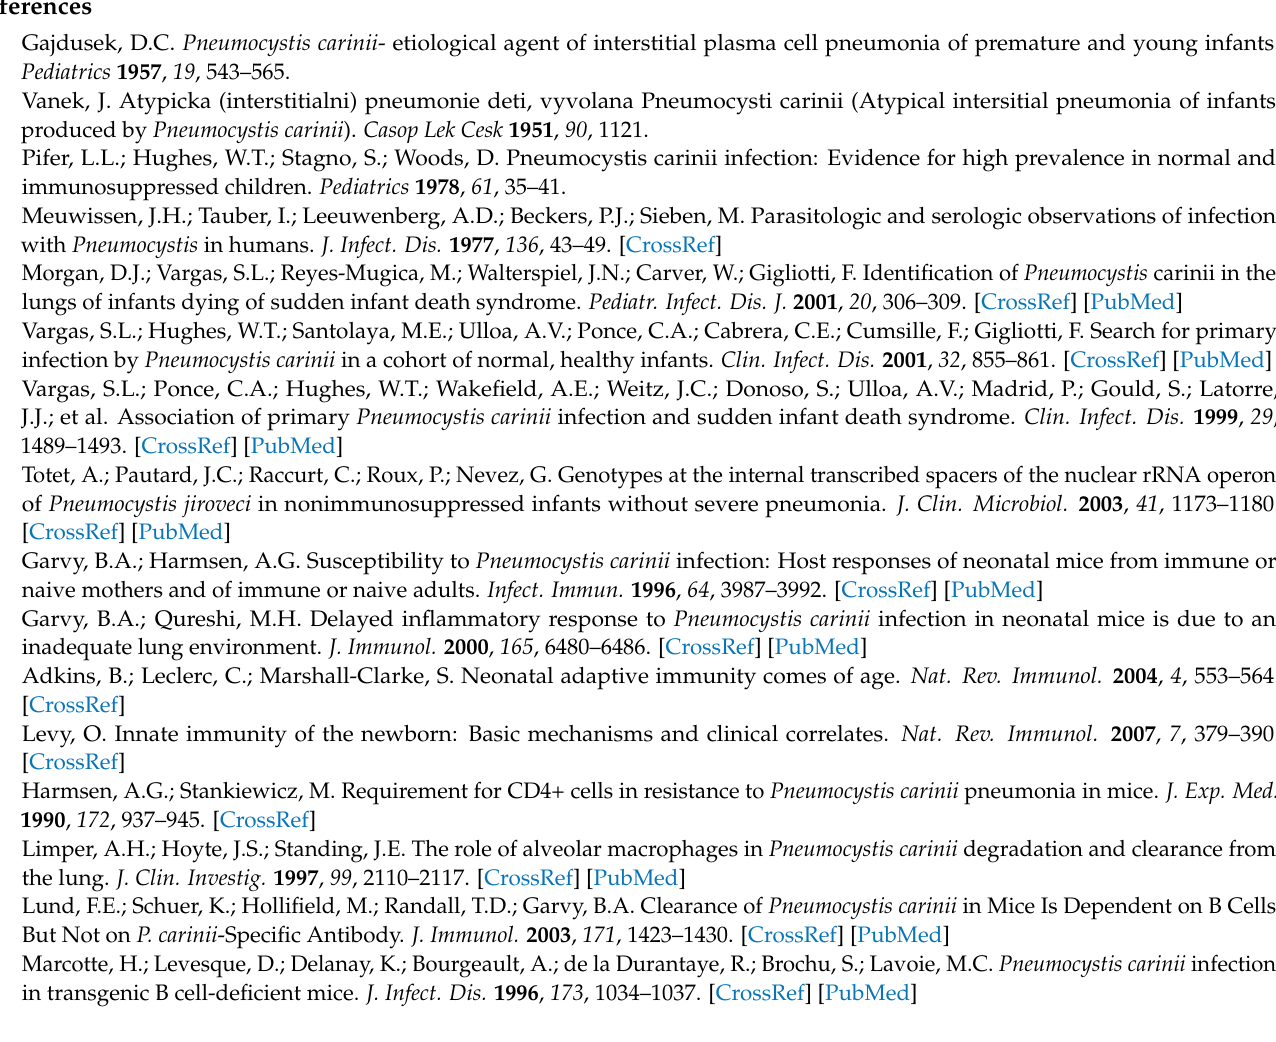
Figure A3. The peak of the cytokine response to P. murina is delayed in neonates compared to adults. 4get mice were infected with P. murina at 2 days and >8 weeks of age. At the indicated time points, BALF was collected from 4–5 mice per group and assayed for IL-13 ( A ), IFN- γ ( B ), or TNF- α ( C ) concentrations by ELISA. Data represents the mean ± SD and are representative of two separate experiments. * p ≤ 0.05 comparing P. murina- infected pups and adults at the indicated time point.